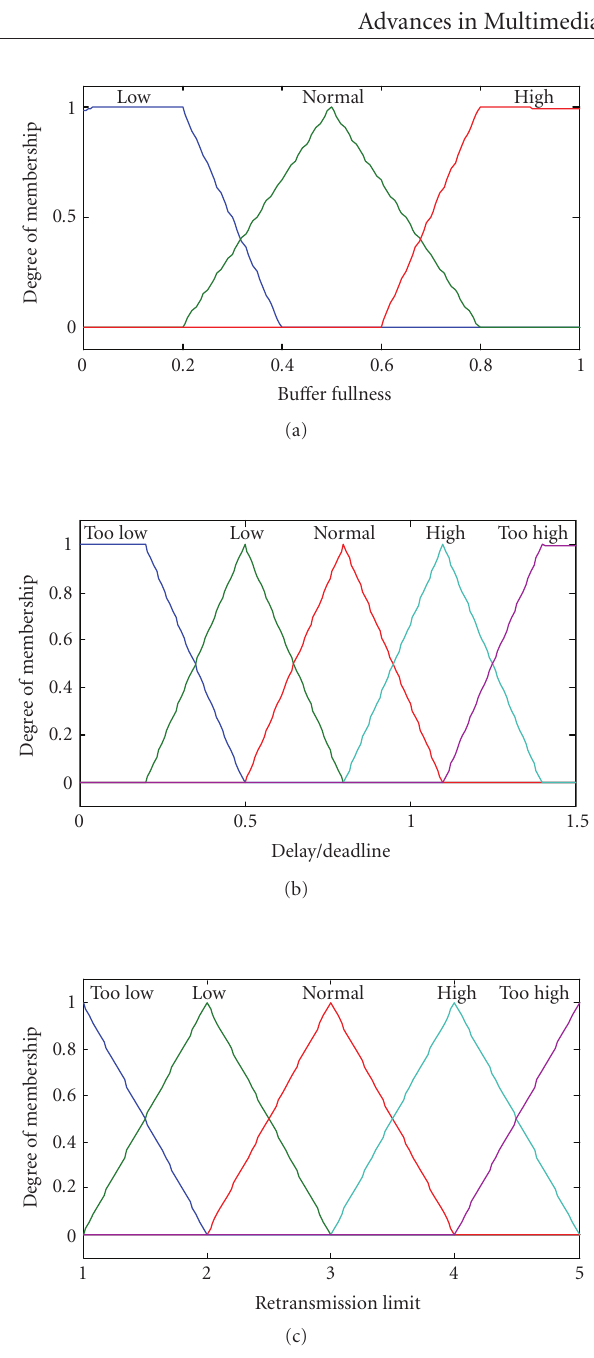
Figure 1: Fuzzy membership functions: (a) input bu ff er fullness (b) input delay/deadline (c) output retransmission